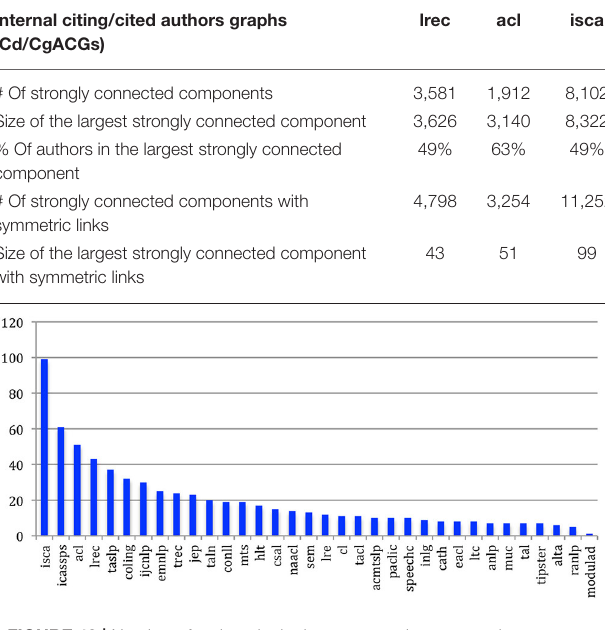
FIGURE 48 | Number of authors in the largest strongly connected component with symmetric links.